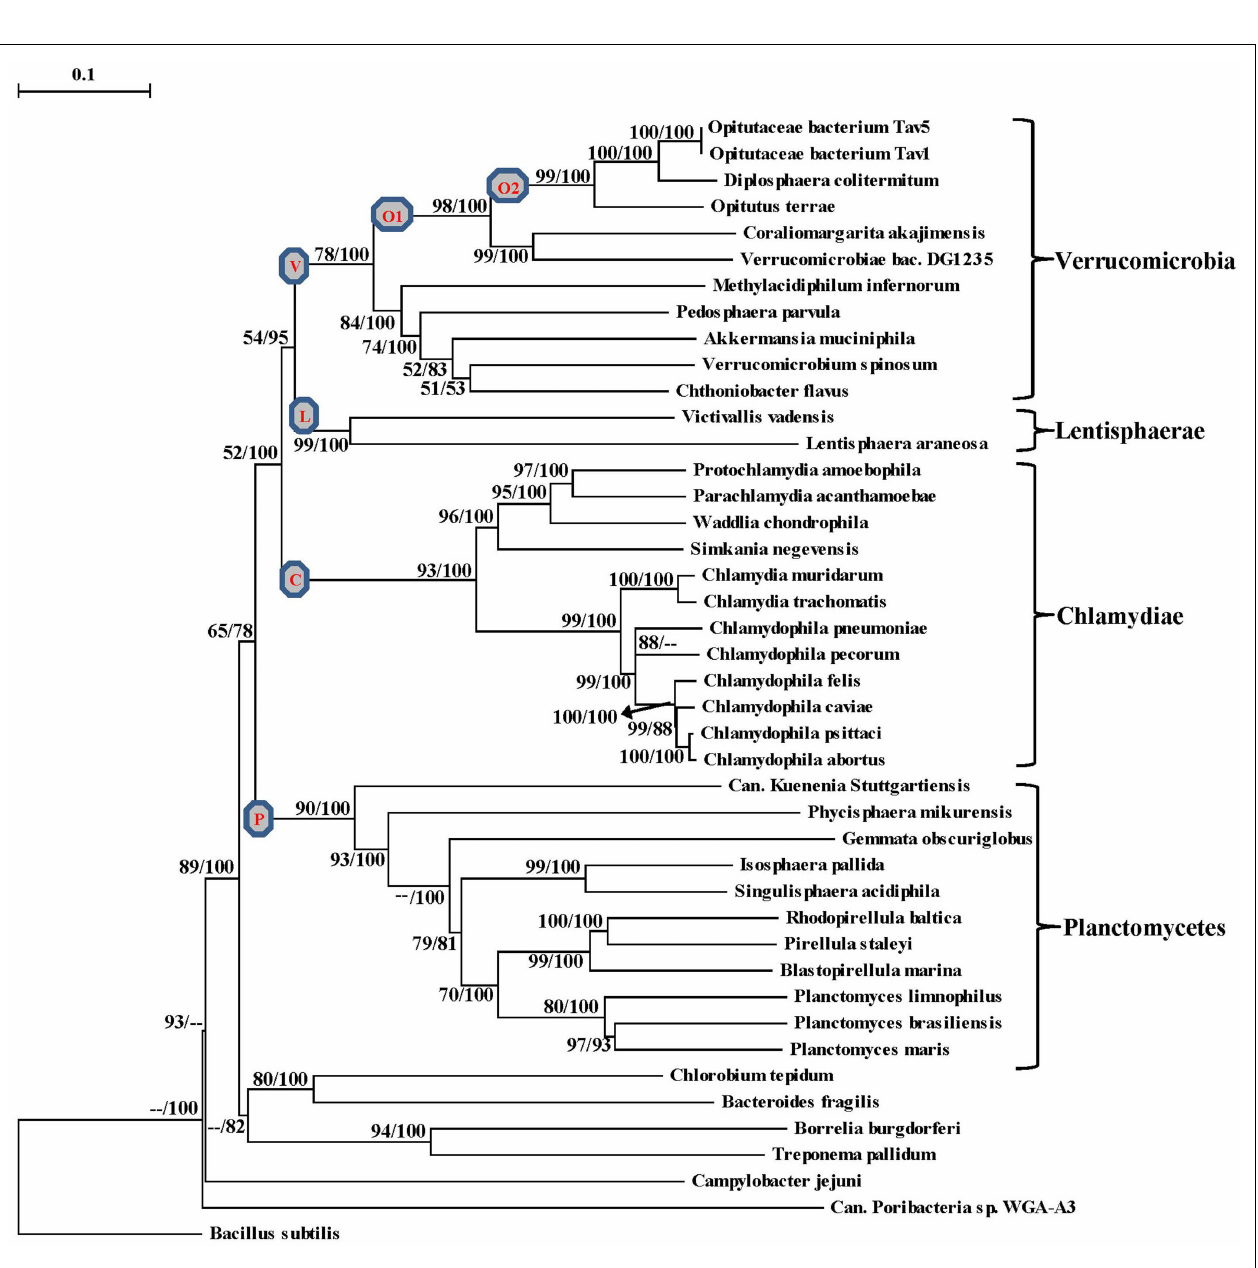
The scores that were less than 50% are not shown and represented by (–). The letters in the circle mark separate clades for theVerrucomicrobia phylum (V), Planctomycetes phylum (P), Chlamydiae (C), Lentisphaerae (L), Opitutae class (O1), Opitutaceae family